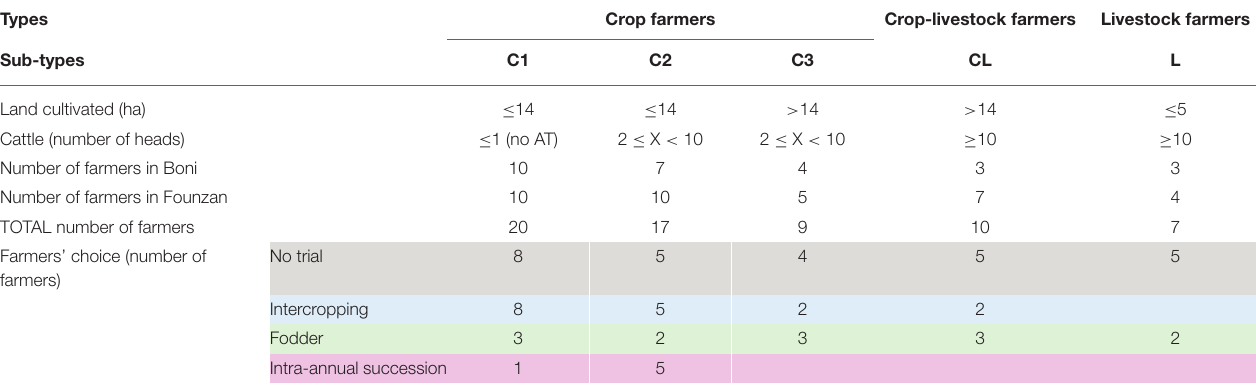
TABLE 4 | Description of the types and sub-types of farmers based on the functional typology proposed by Vall et al. (2006) (no AT: no animal traction), and farmers’ choice of ICS according to their type of farming systems. Types